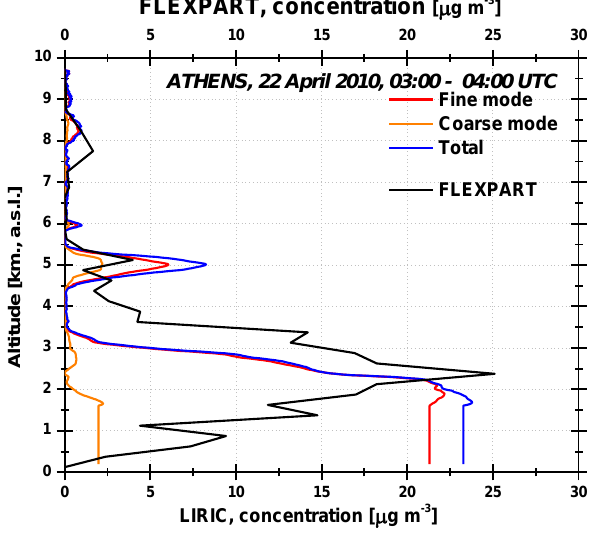
Fig. 4. Aerosol backscatter coefficient profiles (in Mm − 1 sr − 1 ) cal- culated with two different methods, LIRIC (black line) and the Klett technique, at 355 (blue line), 532 (green line) and 1064nm (red line), on 22 April 2010 (03:00–04:00UTC) over Athens.